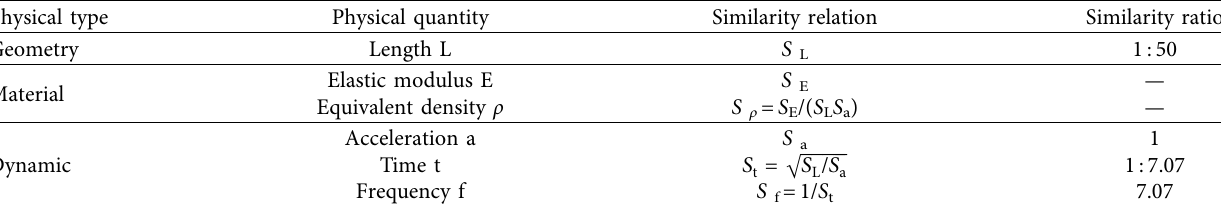
Table 2: Similarity relation of model structure.